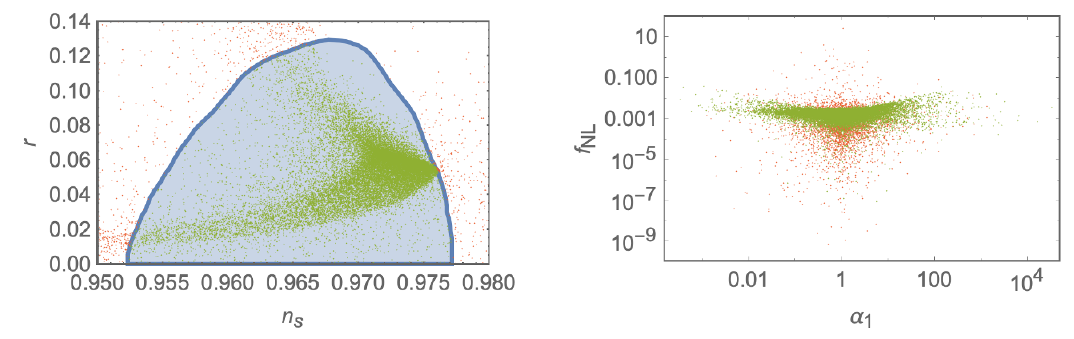
Figure 1 . Left panel: a plot of the ratio r of the tensor to scalar power spectrum vs. the scalar spectral index n s for the two (cid:12)eld DBI model. The blue region enclosed by the blue line is the one allowed by experiment in the 2 (cid:27) range. 85% of the simulated points are consistent with Planck constraints as shown by green points while the red points lie outside the 68% CL contour. Right panel: a plot of non-Gaussianity parameter f equil as a function of (cid:11) 1 for the same data set as in NL the left plot. As in the left panel the green dots are parameter points which satisfy the Planck constraints on r and n s and lie in the blue region and the red dots are parameter points which are outside the experimentally allowed region on r and n s . Points are distributed according to the following: (cid:11) 1 (cid:24) X 0 ; 1 , (cid:11) 2 = (cid:11) 3 = 0, T = 10 (cid:0) 12 M 4 , f (cid:24) X 0 ; 1 M P , ~ (cid:12) (cid:24) X 0 ; 1 , m = 6, P